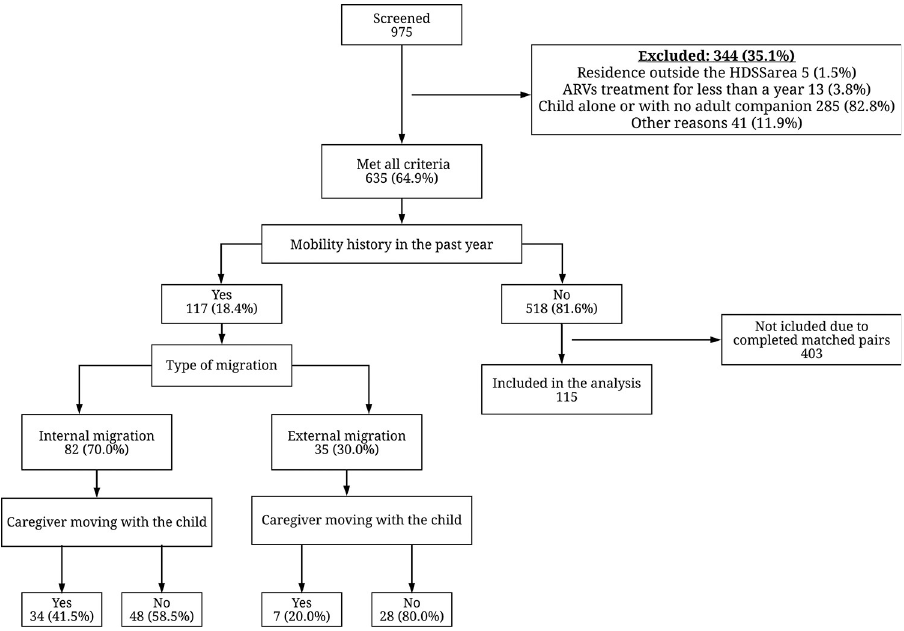
Fig 1. Study profile showing number of patients and reason for not recruiting (December 2017—February